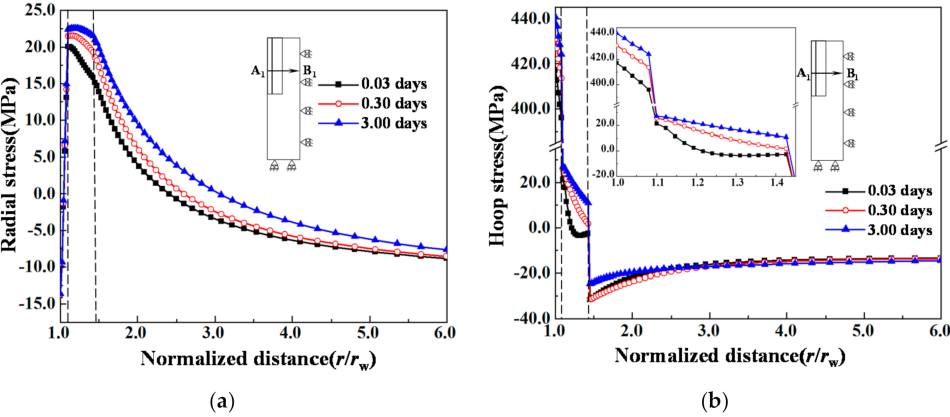
Figure 6. Variations of the stress of the casing-cement sheath-formation (A 1 B 1 ) section with time: ( a ) radial stress; ( b ) hoop